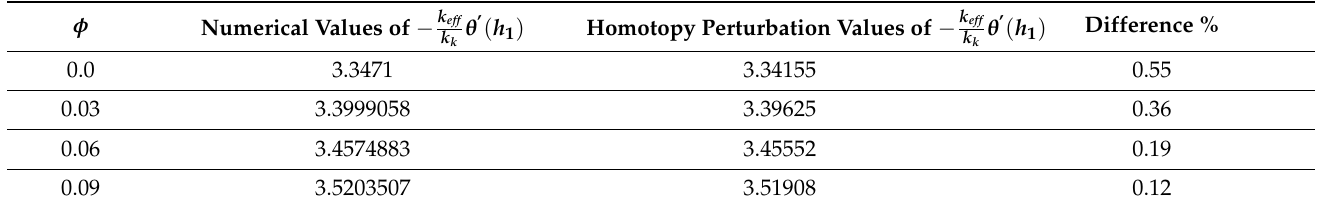
Table 2. Heat transfer rate at the upper boundary by varying nanoparticle volume fraction, where γ = π , α = π , η = 0.8, a = 0.6, d = 0.7, b = 0.5, x = 0, Br = 0.2, k = 2, Gr = 2, m = 1, ∈ = 2, M = 1. 4 4